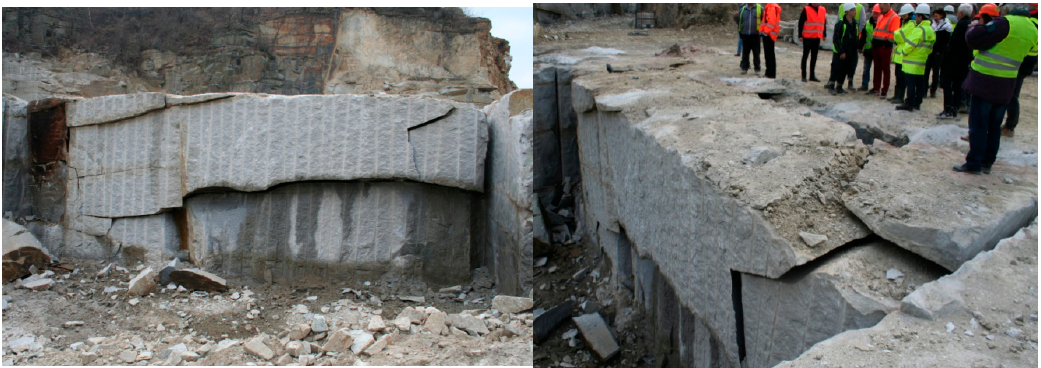
Figure 9. The effect of RSP in a granite deposit. Figure 9. The e ff ect of RSP in a granite deposit.